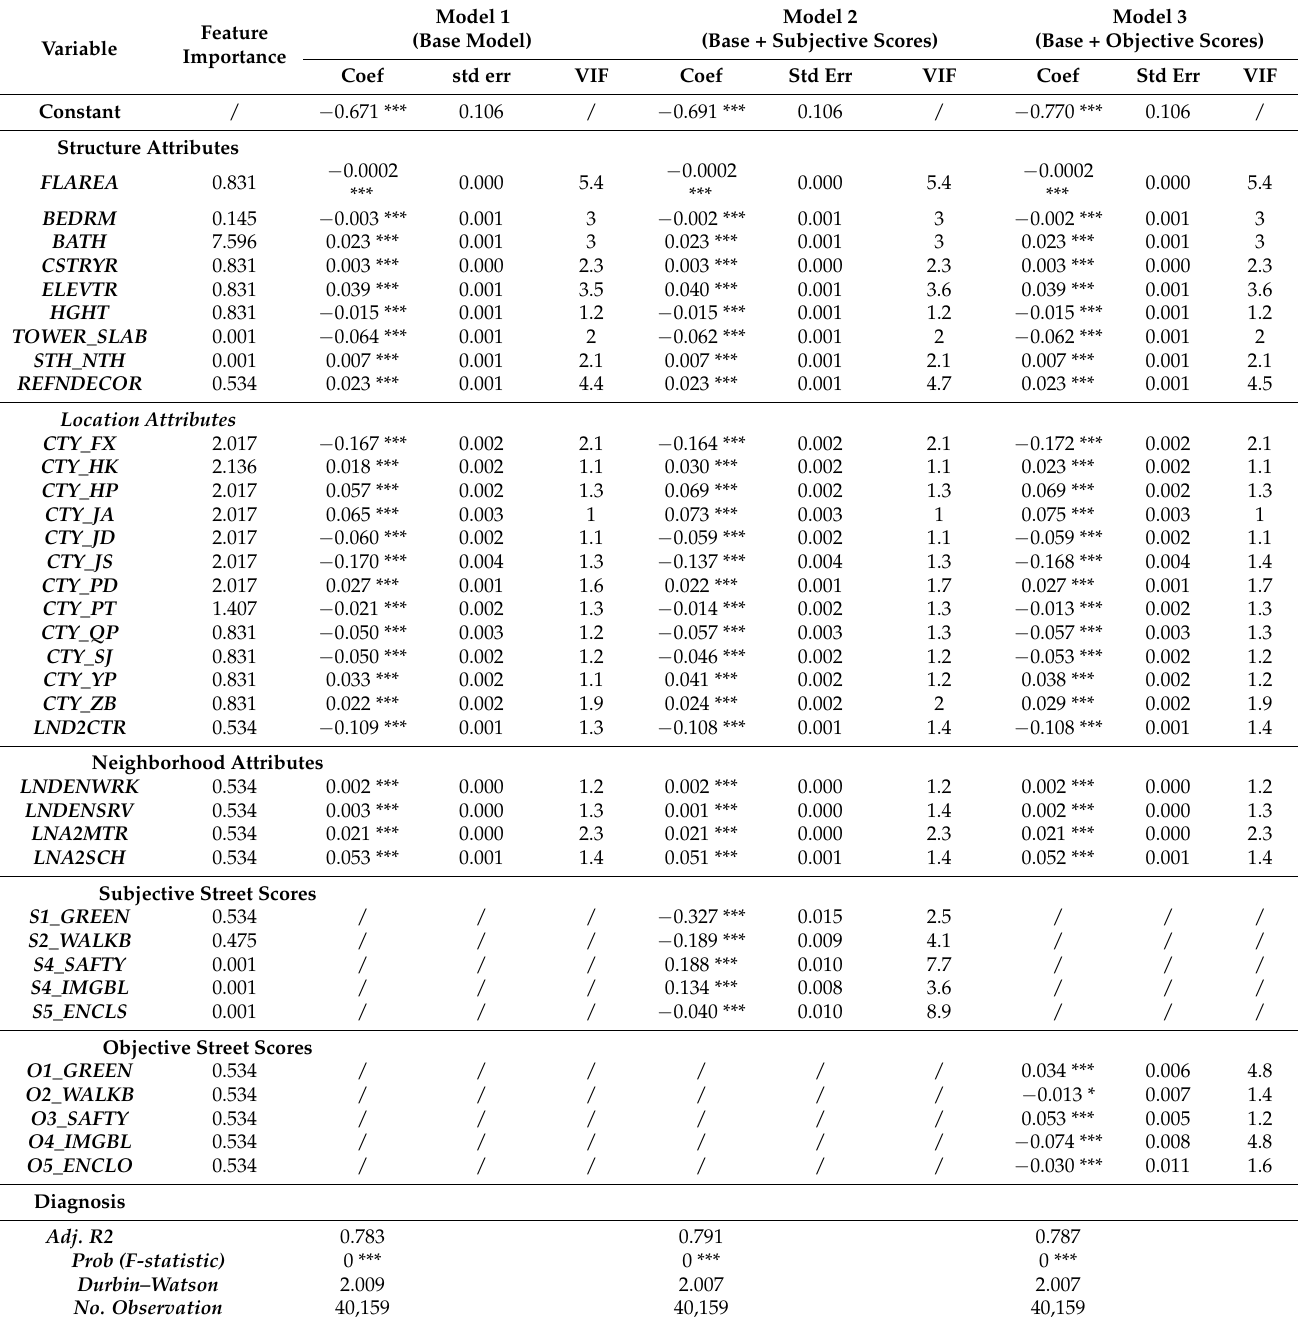
Table 7. OLS regression results and diagnosis for the three